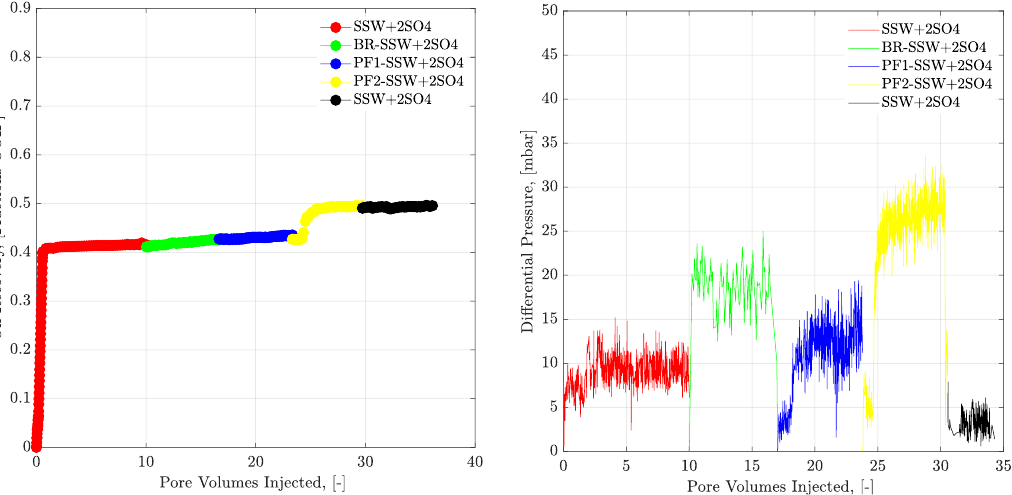
Figure 21. Oil recovery and pressure drop versus PV injected for the complex-wet artificial structure micromodel. Polymer (equal to the oil viscosity) flooding in post-tertiary mode after the SSW+2SO 4 −2 brine flood in secondary mode.